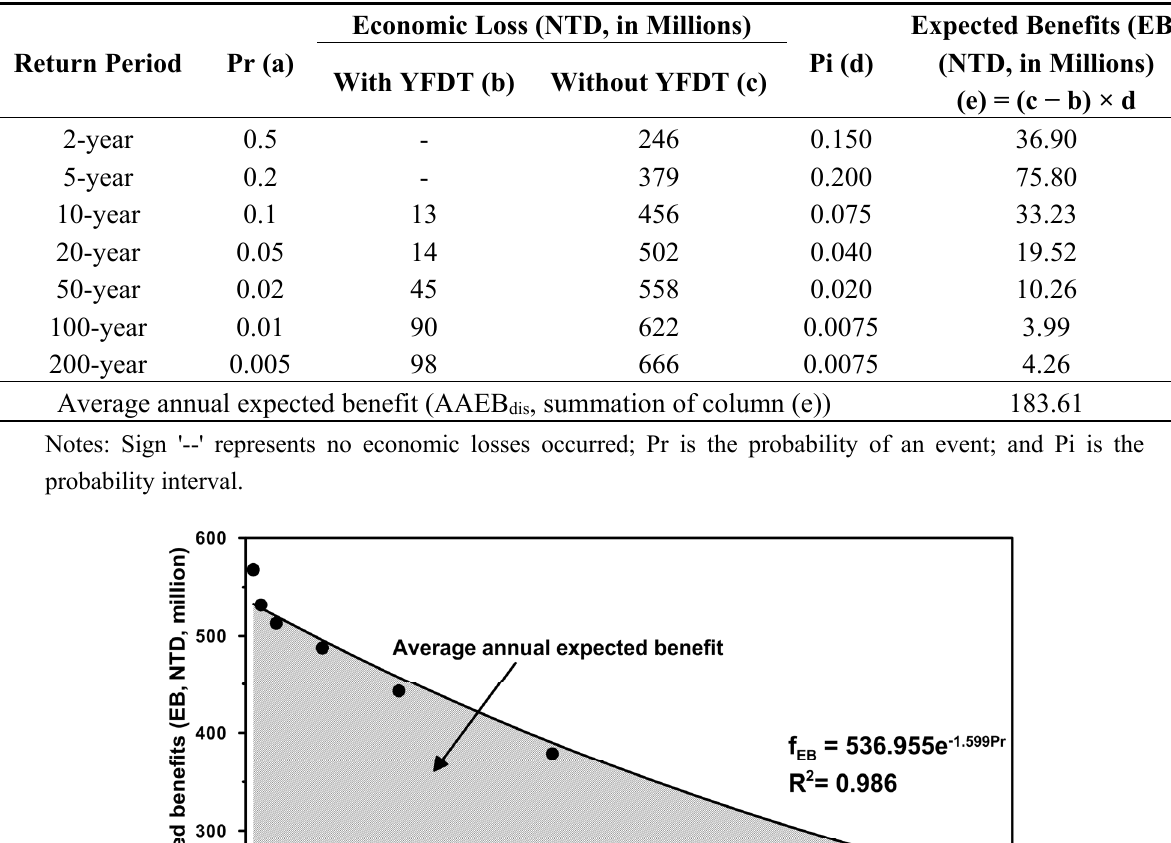
Table 4. Estimation of economic loss and benefit for different return periods with and without YFDT conditions.